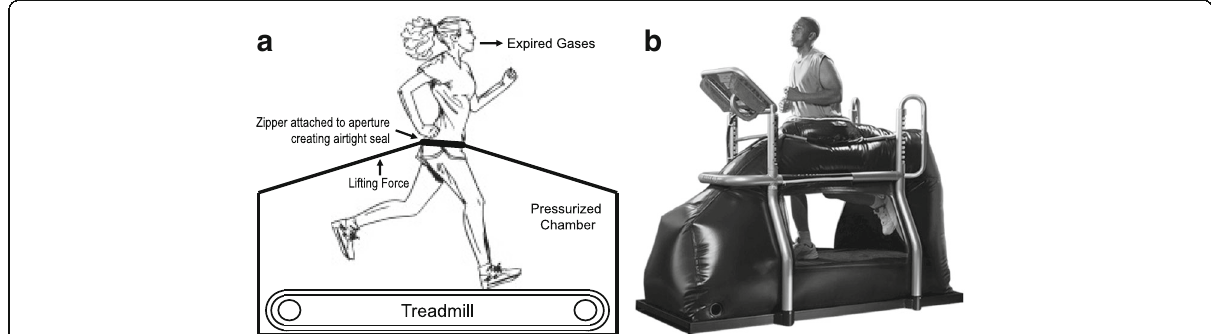
Fig. 1 a Schematic depictions of the lower-body positive pressure treadmill (AlterG Anti-Gravity Treadmill ® P200) used during testing. b AlterG Anti-Gravity Treadmill ® P200. The lower-body positive pressure treadmill uses an enclosed treadmill body weight support system that makes use of the ability to increase air pressure around the user ’ s lower body to create a lifting force near the person ’ s center of mass. The pressurized chamber contains an aperture surrounding the subject ’ s waist. Each subject wore a pair of flexible neoprene shorts that included a kayak-style spray skirt and a zipper attached to the aperture allowing for an airtight seal around the waist. Expired gases were continuously collected and measured using a metabolic cart, and biomechanical measures were assessed using high-speed video